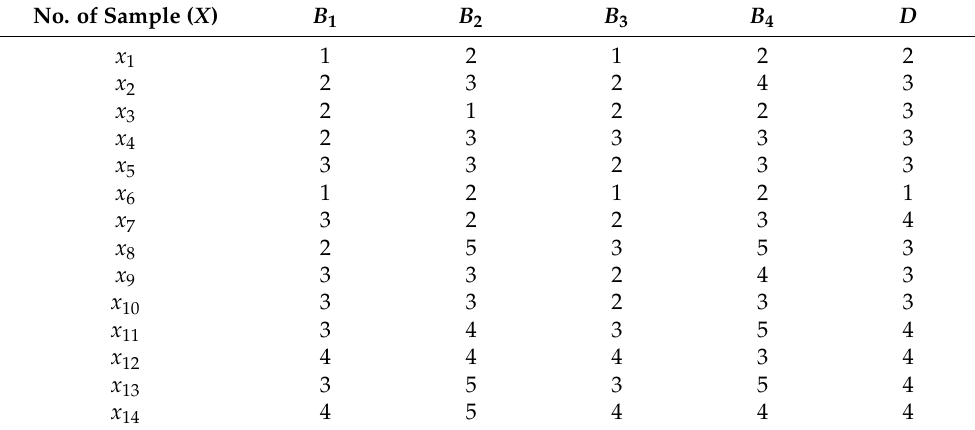
Table 3. Sample data discretization of criterion